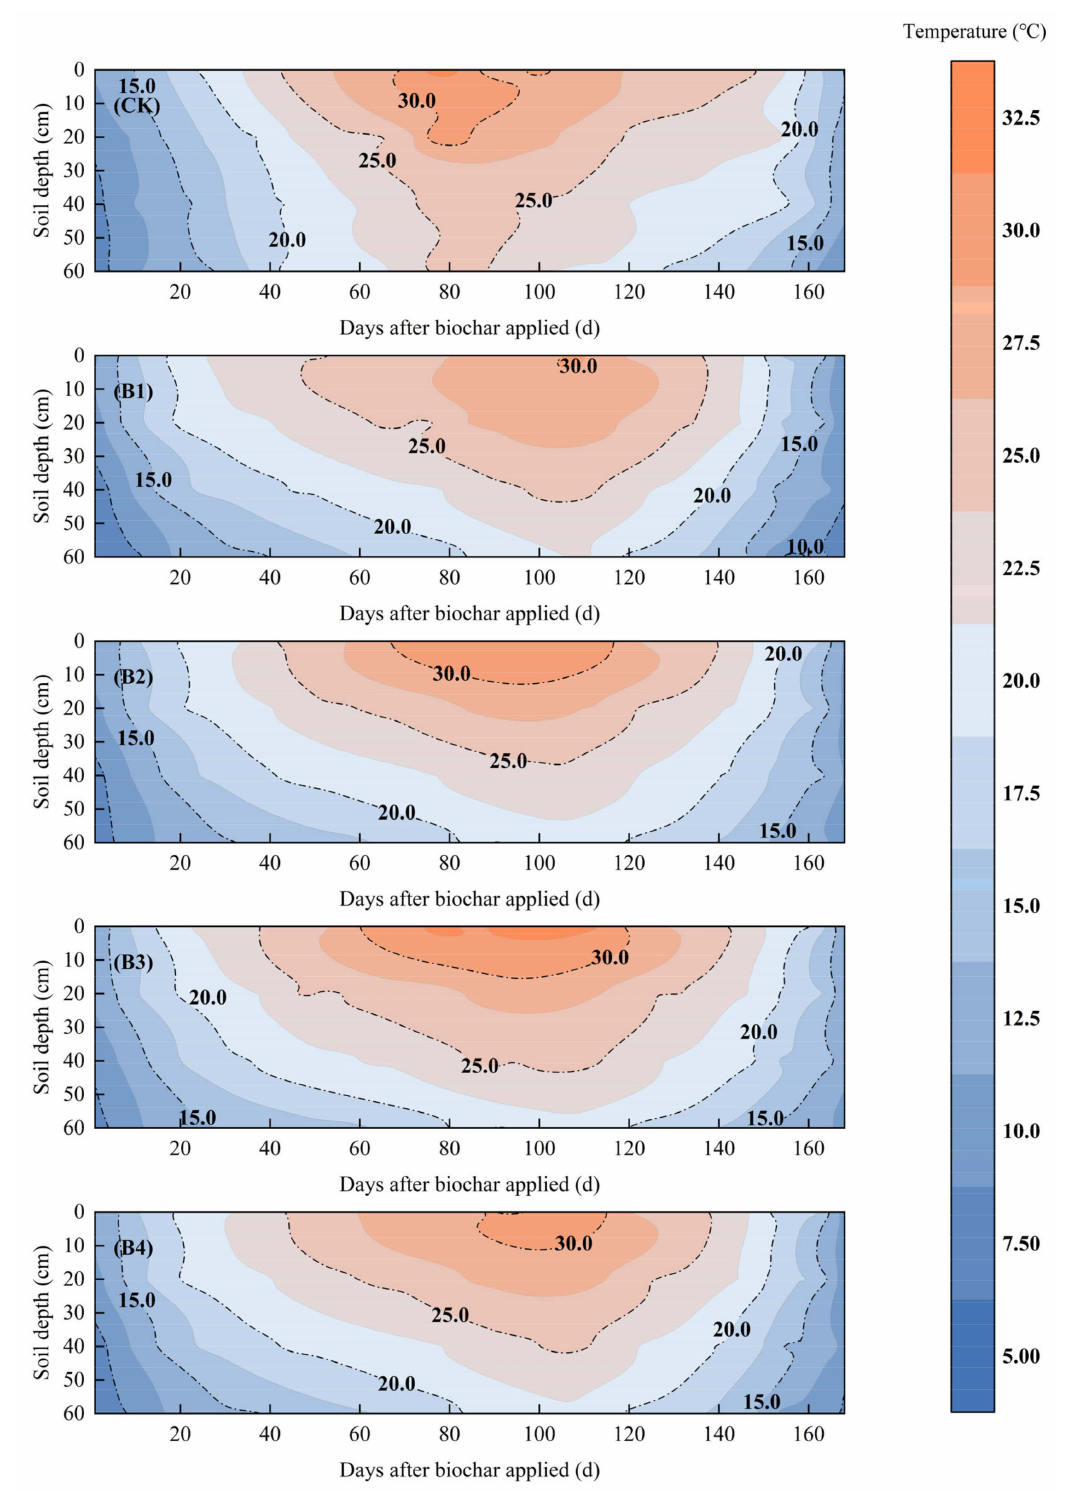
Figure 5. Soil temperature of treatments B and CK in 0–60 cm during the cotton growth stage. In the vertical direction, the soil temperature of each treatment decreased with the increase in depth. Treatments B experienced two times of tillage before and after freeze- thaw, and the biochar soil mixture and distribution were more uniform. This mixture led to the best warming effect of treatment B’s soil temperature under film mulching, slightly better than treatments A’s, although it required more